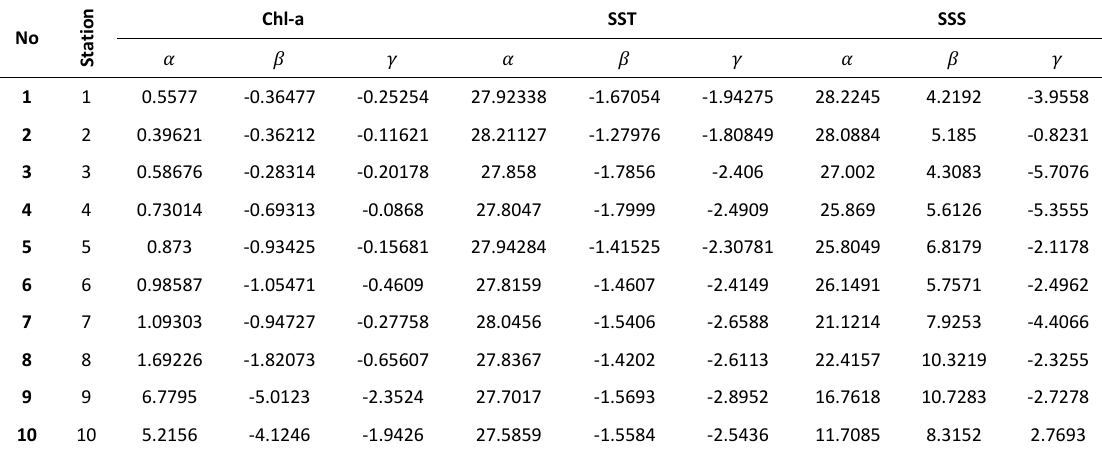
Table 2: Constant and coefficient of predictor